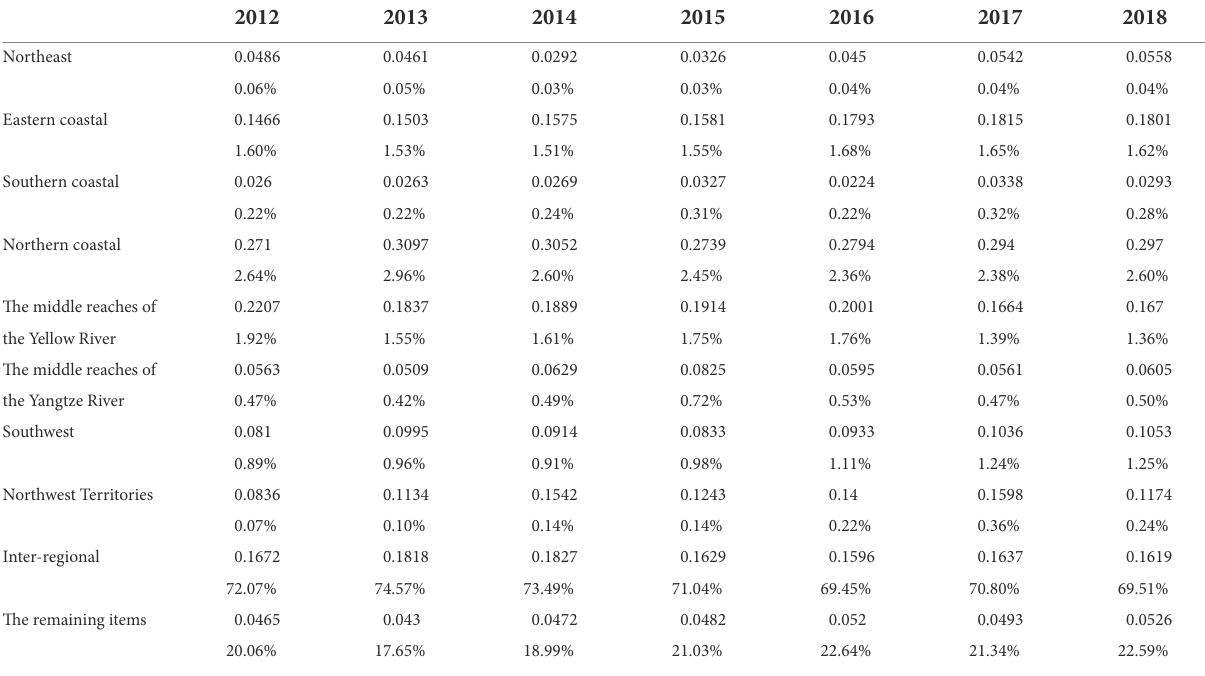
TABLE 9 Gini coefficients for intra-regional education funding and their contribution to overall